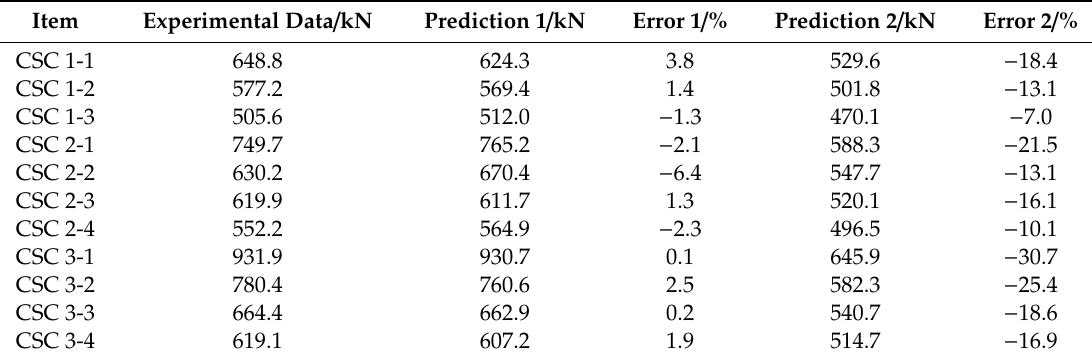
Table 2. Comparison of the calculated results and experimental data of specimens’ AULC. Item Experimental Data / kN Prediction 1 / kN Error 1 / % Prediction 2 / kN Error 2 /